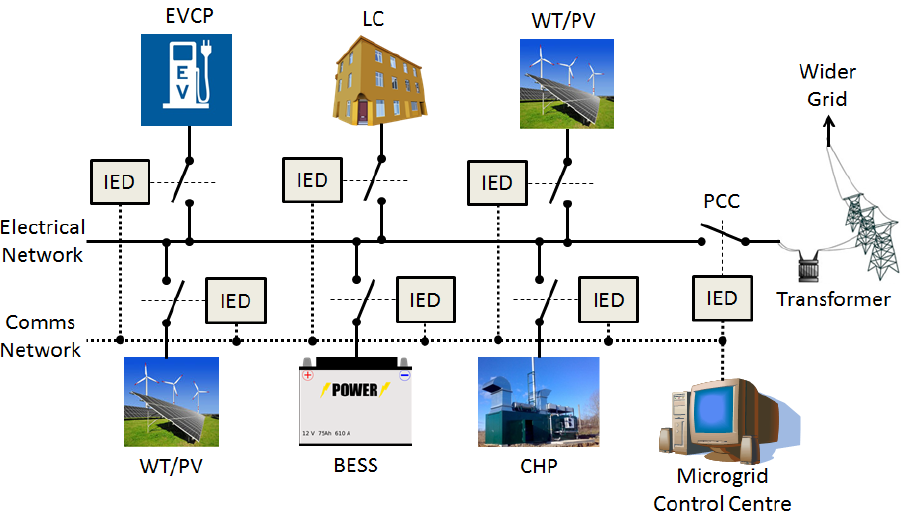
Figure 1. Typical layout of a microgrid and its constituent components.